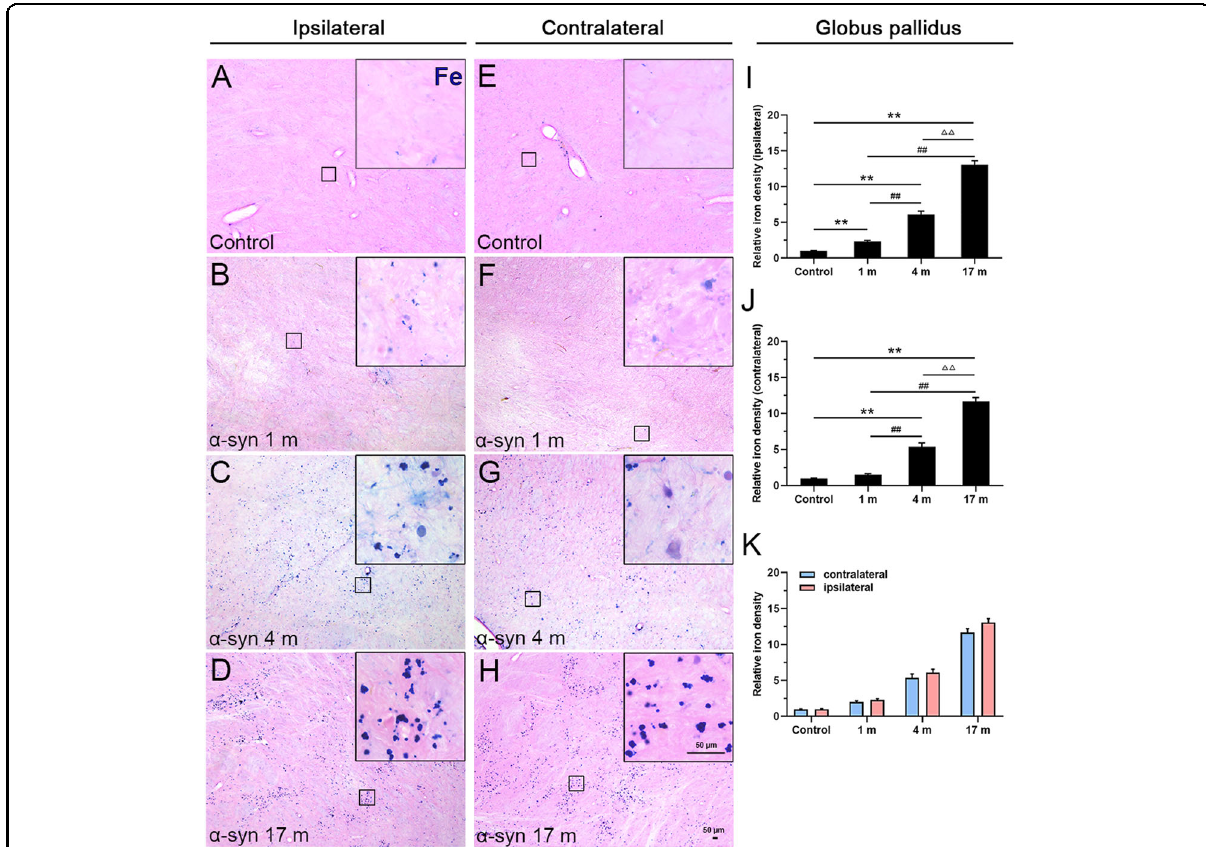
and 17 months ( D ) after the α -syn PFFs treatment, compared to the control ( A ) in the ipsilateral side. E – H Chemical staining of iron ions in the control ( E ) and 1 ( F ), 4 ( G ), and 17 months ( H ) after the treatment with α -syn PFFs in the contralateral side. The inset images depict the enlarged small boxes in A – H . I – K Quantitative analyses of the iron deposition density in the globus pallidus (ipsilateral side: I ; contralateral side: J ; both sides: K ). α -Syn, α - synuclein. The data are presented as the mean ± SEM of three independent experiments. ** p < 0.01 vs. control group, ## p < 0.01 vs. 1-month group, ΔΔ p < 0.01 vs. 4-month group, one-way ANOVA ( I , J ). Scale bars: 50 μ m in A – H and 50 µm in the